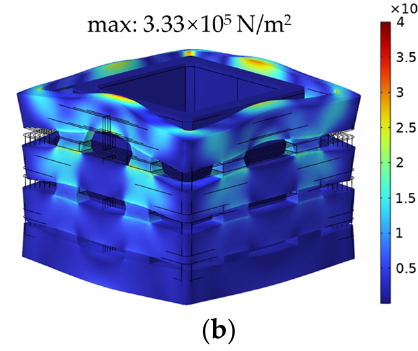
Figure 14. Stress distribution under end-winding short circuit ( a ) Interleaved winding; ( b ) Continuous winding.